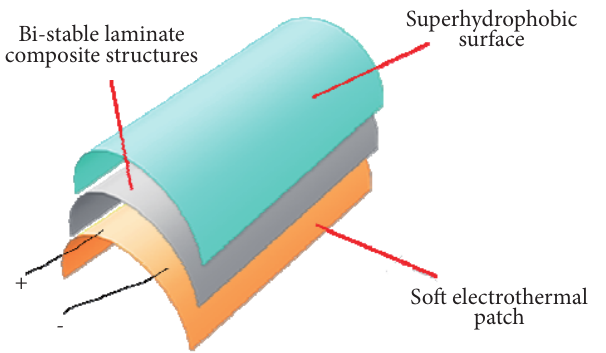
Figure 16. Schematic diagram of the anti-icing/deicing system (Zhang et al. 2017b).